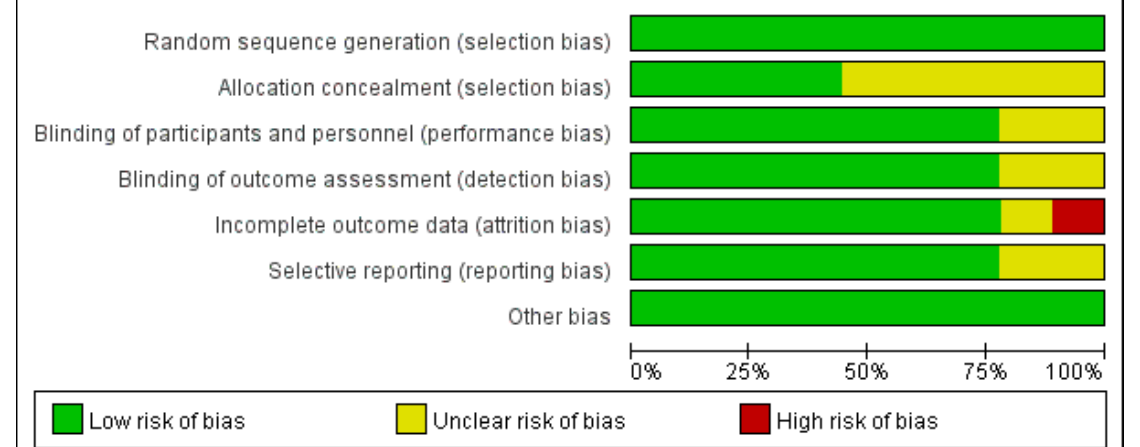
Figure 3. Risk of bias summary for the studies assessed.